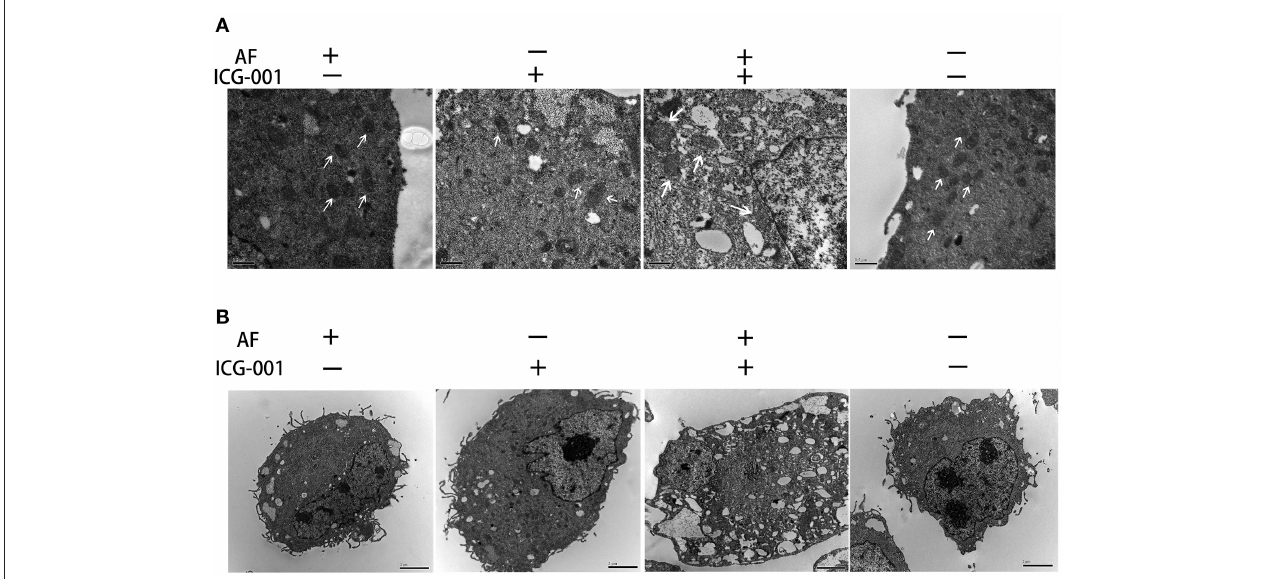
FIGURE 4 | Combination of AF and ICG-001 causes mitochondrial damage. (A) The TEM images of mitochondrion. Arrow: mitochondrion. Bar, 0.5 µ m. (B) The TEM images of cell morphology. Bar, 2 µ m.